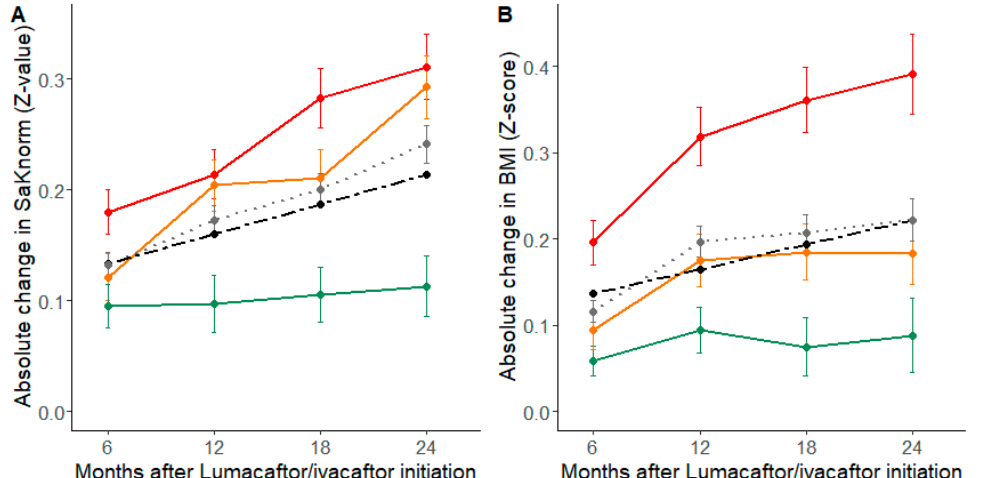
Figure 2. Change according to baseline terciles following initiation of combined lumacaftor/ivacaftor therapy with 95% CIs in ( A ) lung function (SaKnorm Z-value), and ( B ) nutritional status (BMI Z-score), in 765 people with cystic fibrosis (pwCF). For lung response analysis, the baseline SaKnorm (Z-value) terciles were from − 1.620 to 0.168 (1st tercile in red), from 0.169 to 0.791 (2nd tercile in orange) and from 0.792 to 2.520 (3rd tercile in green). For nutritional response analysis, the baseline BMI (Z-score) terciles were from − 4.330 to − 1.080 (1st tercile in red), from − 1.079 to − 0.307 (2nd tercile in orange) and from − 0.306 to 2.890 (3rd tercile in green). The black dotted lines show the model predicted change and the grey dotted lines the overall change in the 765 pwCF. At 6 months post-treatment, the pwCF in the baseline 1st tercile had an increased ppFEV 1 of 2.68 ± 0.25% predicted and of 0.49 ± 0.02 kg/m 2 for BMI (Table S1). Gender was not associated with lung function response, but females had a higher nutritional response ( p -value = 0.04) (Table 2 and Figure 3A). At initiation of LUMA-IVA, the baseline nutri- tional status of women ( − 0.805 ± 0.992 of BMI Z-score) was more impaired than men ( − 0.642 ± 0.931 of BMI Z-score). After 2 years of LUMA-IVA, both men and women had a similar nutritional status ( − 0.511 ± 0.931 and − 0.522 ± 0.922 for BMI Z-score for men and women, respectively) (Figure 3B). Figure 3. Nutritional status (BMI Z-score) over 2 years following initiation of combined lu- macaftor/ivacaftor therapy according to gender with 95% CIs, ( A ) mean of absolute changes from baseline, ( B ) mean of BMI Z-score, in 765 people with cystic fibrosis (pwCF). Men are in blue, women in orange and the dotted lines show the overall change in the 765 pwCF.